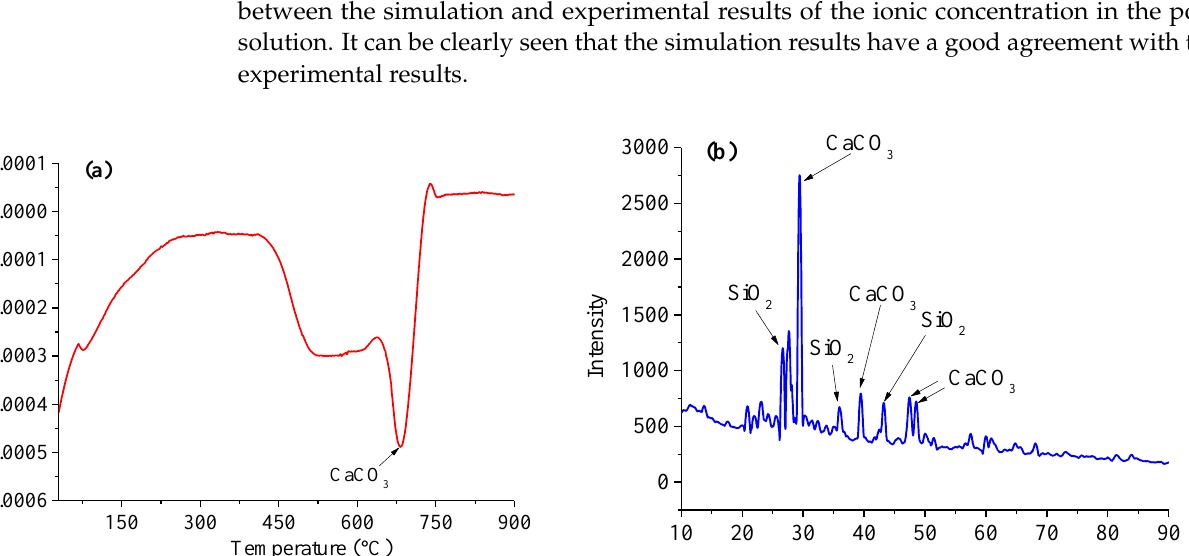
Figure 7. Weights of the dried specimens before and after the carbonation.